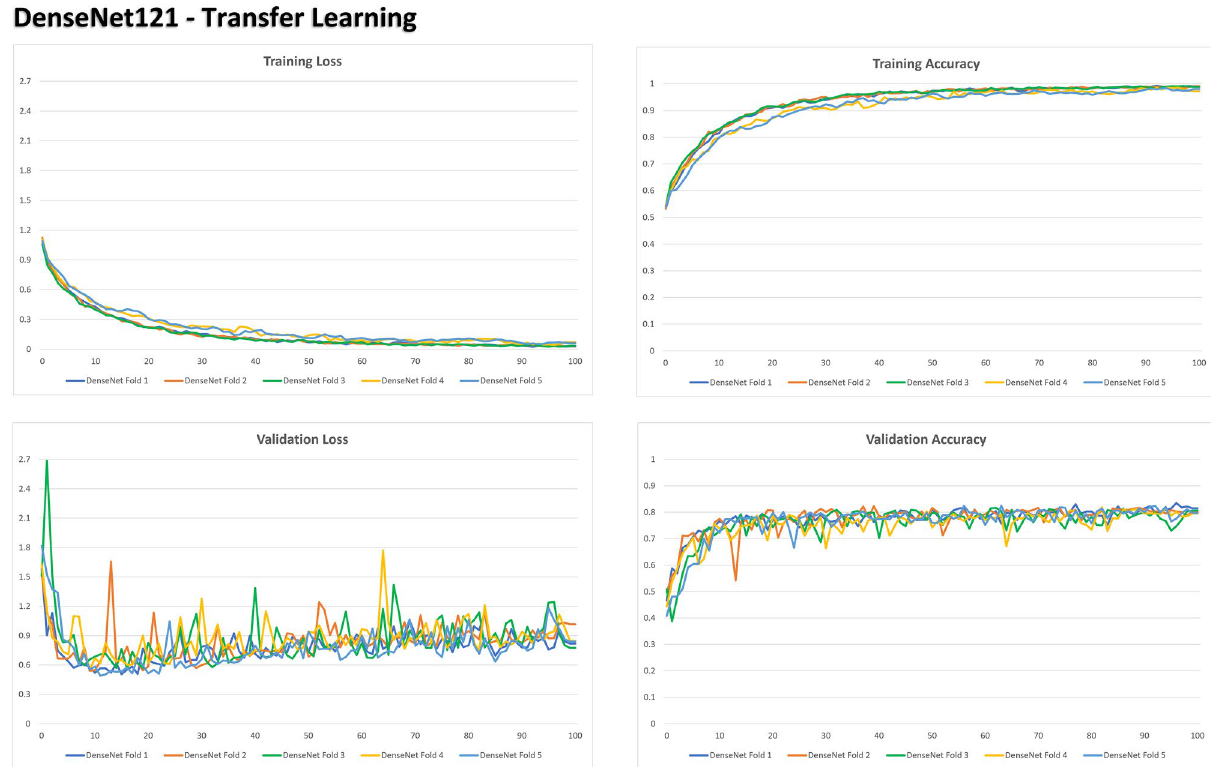
Figure 3. Graphs representing the loss and evolutionary accuracy of the training process and learning validation with Transfer Learning (TL) architecture in DenseNet121.